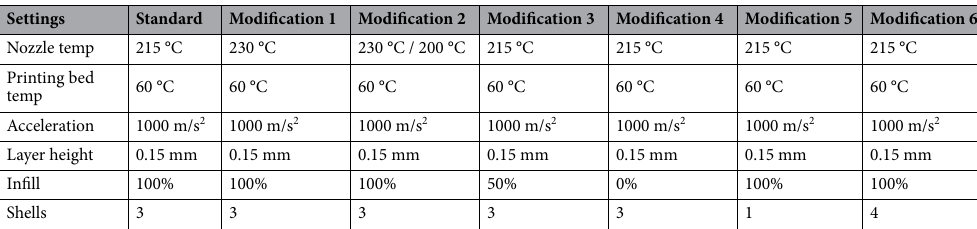
Table 1. Standard printing parameters and modified